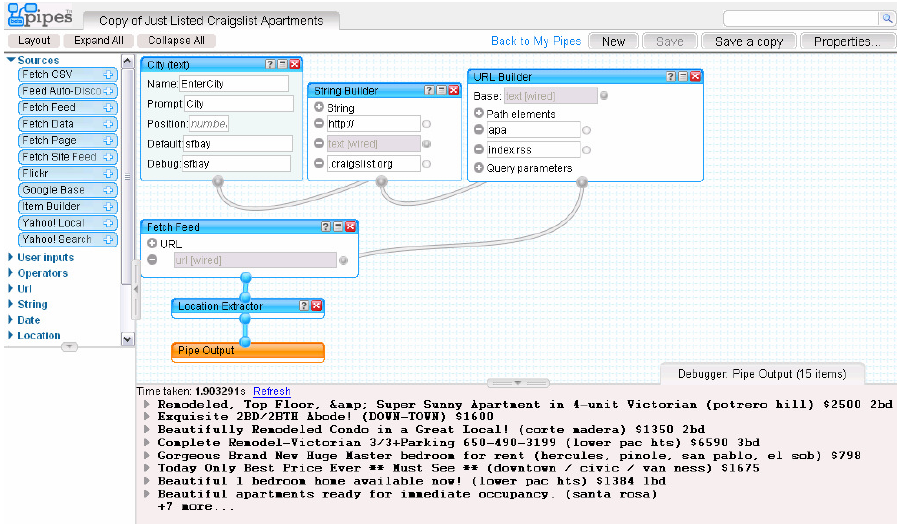
Figure 8. HousingMaps programmed in Yahoo! Pipes.